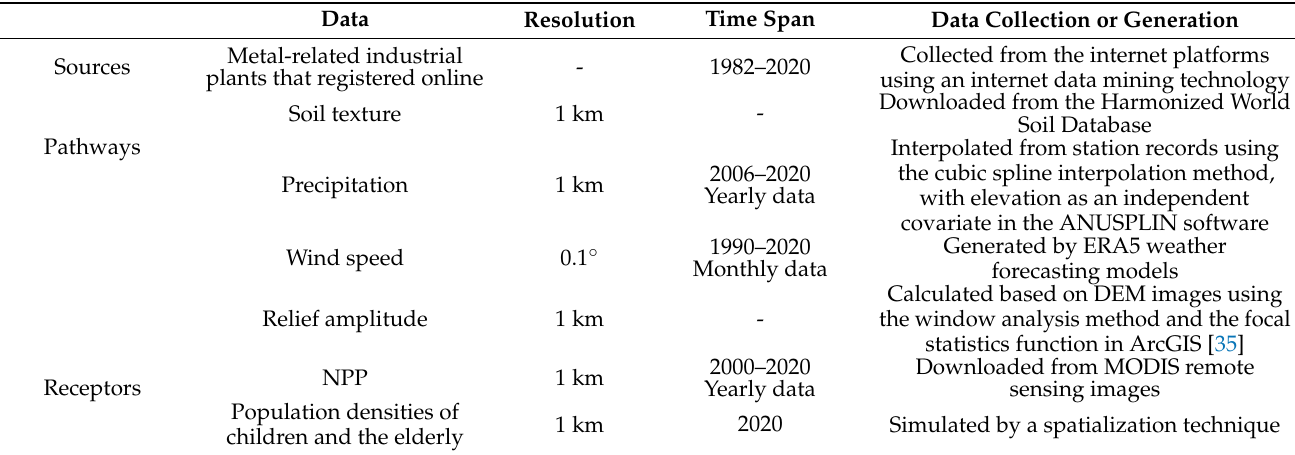
Table 1. Description of the data used in this